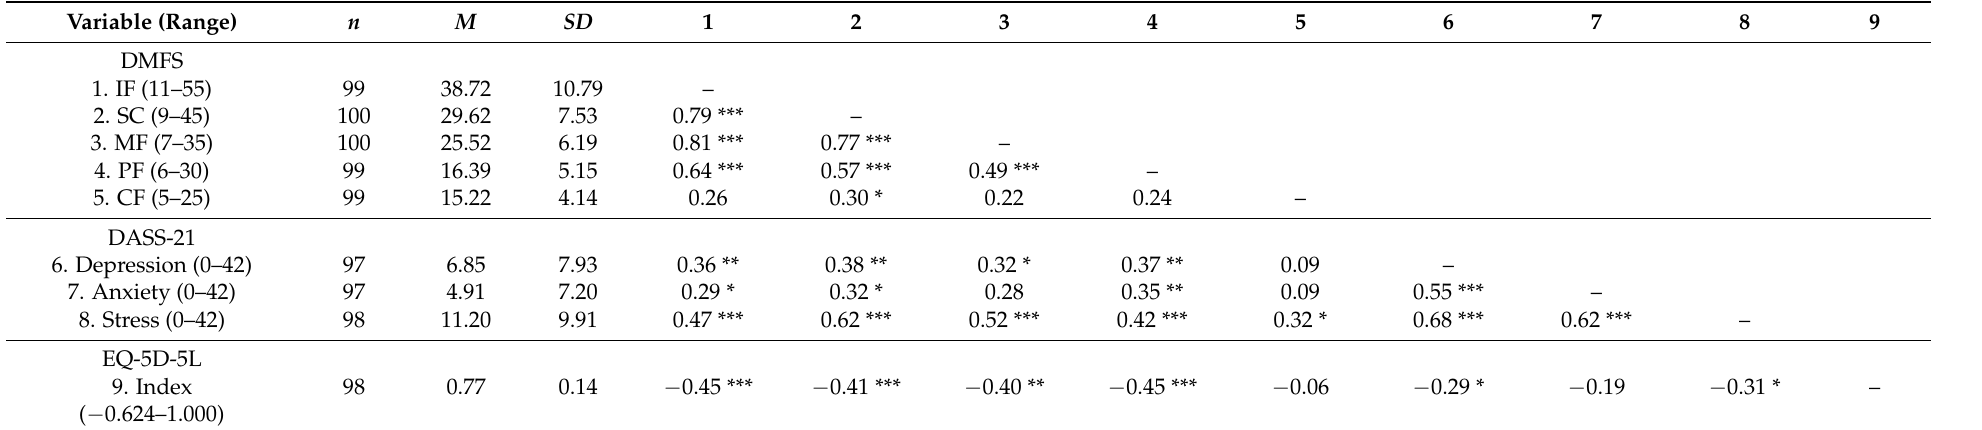
Table 4. Descriptive statistics and pairwise correlations in community-based rehabilitation ( n =